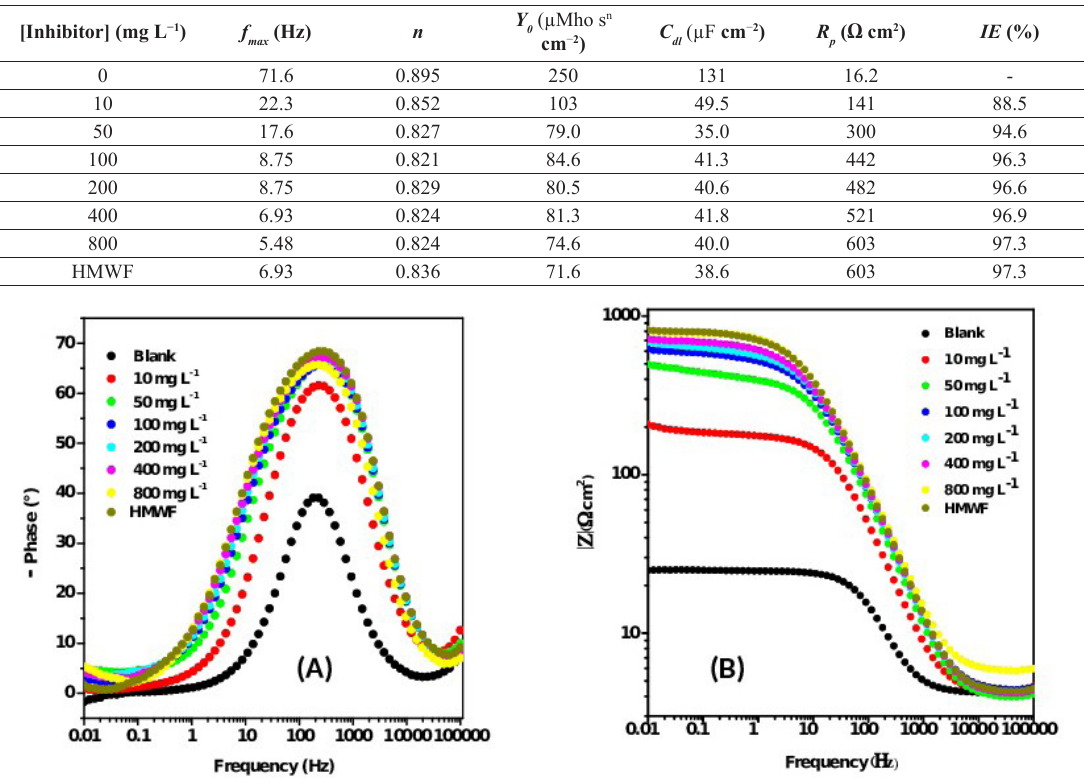
Table 4. Electrochemical parameters acquired from the EIS diagrams in the absence and presence of ACSE and its HMWF.